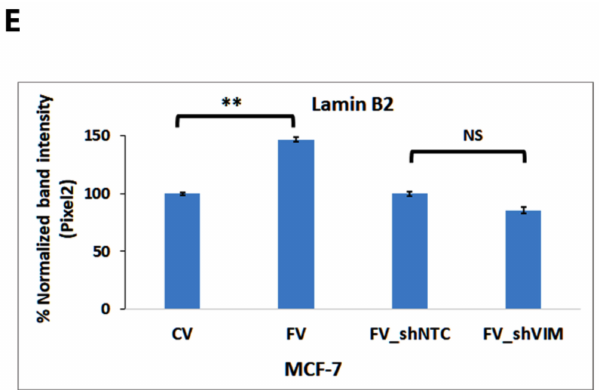
Figure 7. Effect of vimentin on the expression of nuclear lamins in MCF-7 cells. ( A ): Lamin expression in MCF-7CV, MCF-7FV cells and after transduction of MCF-7FV with shVIM and NTC to produce MCF-7FV_shVIM and MCF-7_shNTC cells was determined by Western blotting. A total of 10 µ g protein was loaded for each cell line and probed with anti-lamin A/C, B1 and B2 antibodies. GAPDH was used as the loading control. Relevant bands were cropped from different gels and regrouped. Original blots are shown in Supplementary Figure S8. ( B ): Quantification of the band intensity of lamin A indicated significant downregulation ( p < 0.05) in MCF-7FV as compared to CV whereas significant upregulation ( p < 0.05) was seen in MCF-7FV_shVIM as compared to MCF- 7_shNTC. ( C ): Quantification of the band intensity in case of lamin C indicated a repressed